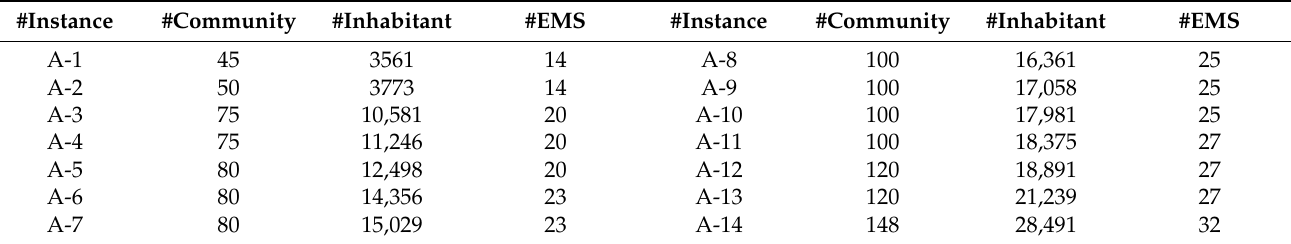
Table 8. Details of 14 randomly generated test instances.